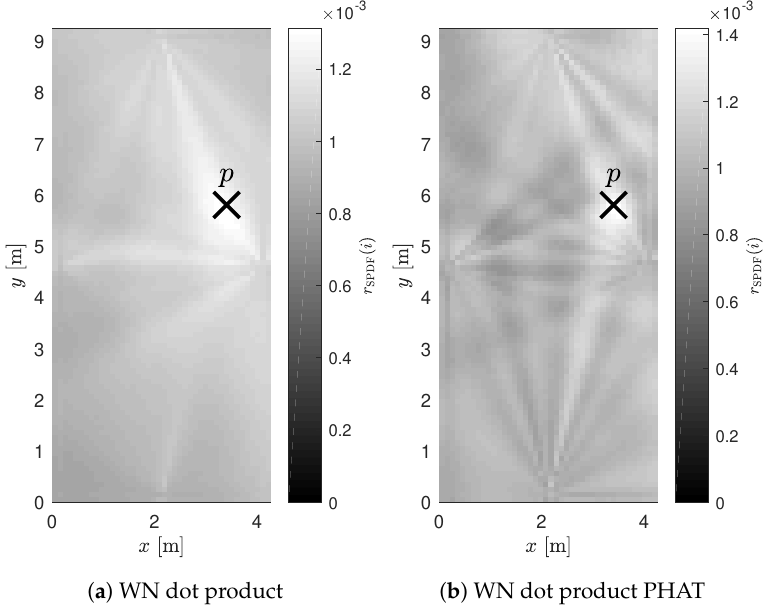
Figure 7. Example of the merged SPDFs for four nodes in a rectangular room where p is the actual position of the sound